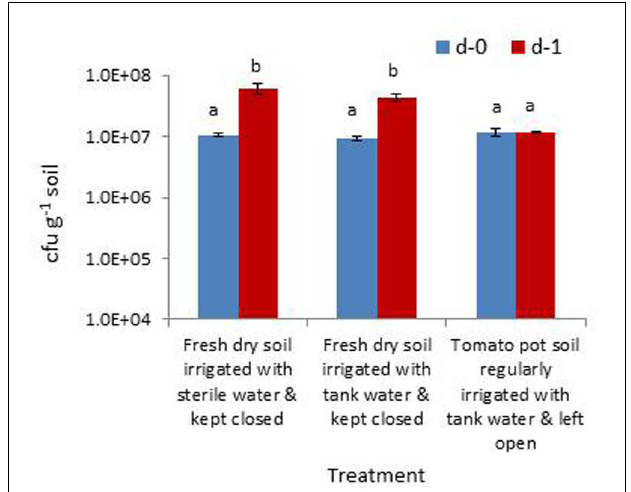
FIGURE 6 | Assessing the extent of increase in gross bacterial cfu due to the moistening of dry rhizospheric soil mix with sterile water, the contribution from irrigating water and the monitoring of rhizospheric soil of tomato (Bars with same letters are not significantly different at P = 0.05).